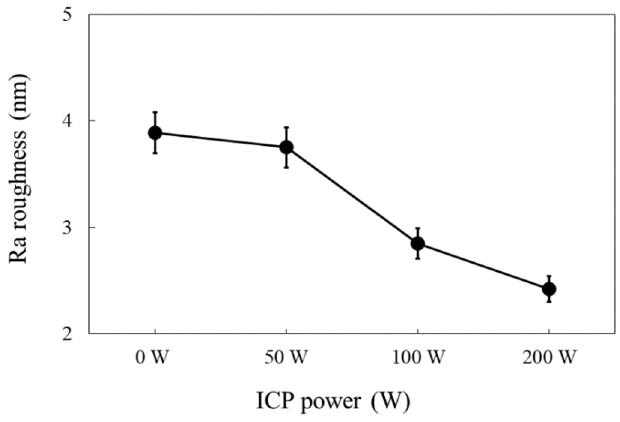
Figure 5. Surface roughness of MoN coatings deposited using ICP assisted sputtering with various ICP powers .